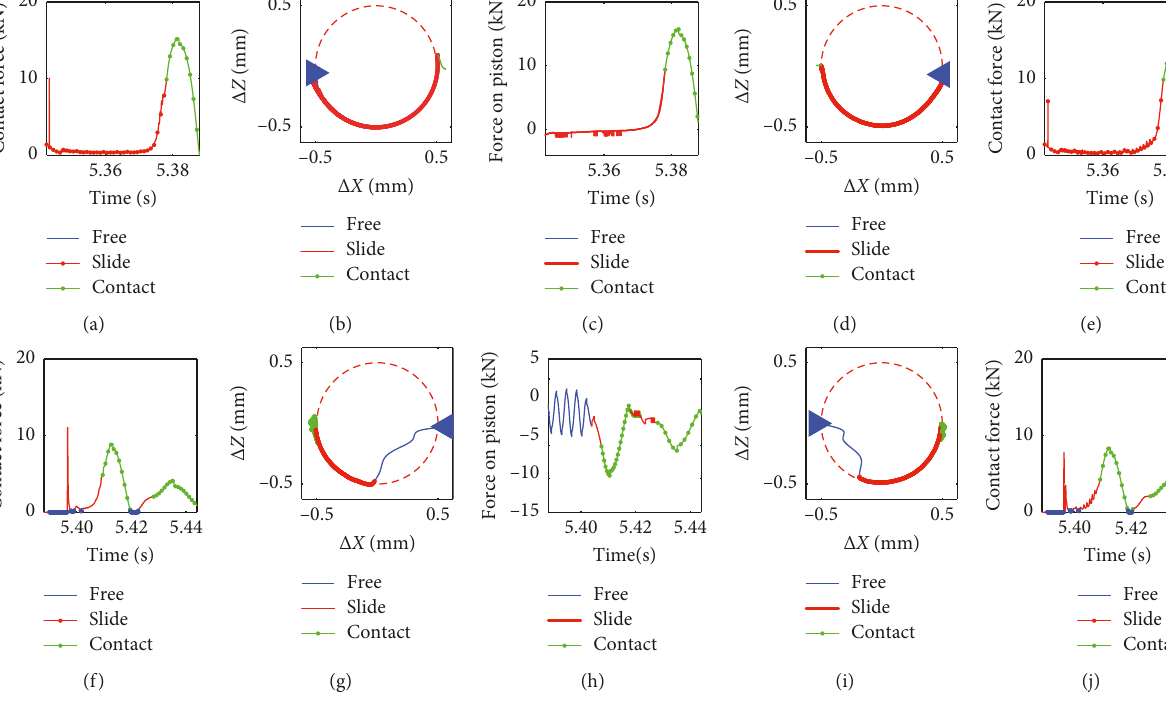
� 0.5 and c � 0.5: (a, f) contact forces in the a r